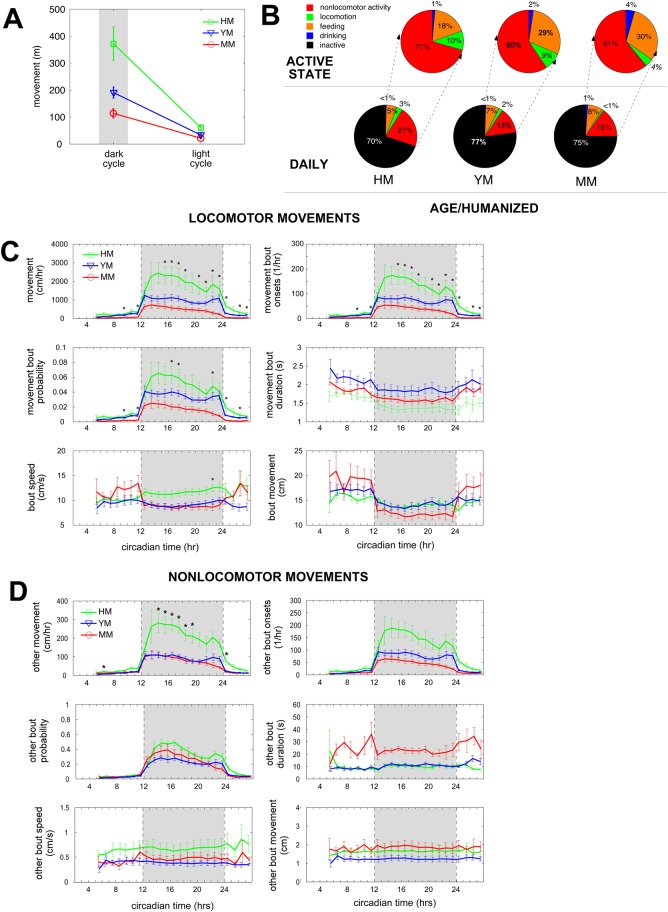
Mouse home cage behavior monitoring. Humanized mice (HM) have significantly more dark cycle movement as a result of higher dark cycle movement probability and greater dark cycle movement bouts. (A) Overall movement averages for dark cycle (grayed) and light cycle for humanized, young male (YM), and middle age male (MM) mice (green, blue, red traces respectively). Bars are ±one standard error of the mean. (B) Time budgets show that over 24 h, HM mice have significantly less inactive time compared to YM and MM mice, with a similar increase in nonlocomotor movements (bottom row). Active state time budgets between YM and MM mice are similar except that MM mice show less locomotion compared to YM mice. HM mice active state time budgets are similar to YM, except that HM mice show significantly more nonlocomotor movements, and significantly less time dedicated to feeding, compared to YM mice. (C) Locomotor movement properties. Note that HM mice show increased overall locomotion, locomotor probability, and locomotor bouts compared with either YM or MM mice (asterisks indicate time bins where HM mice significantly differ from YM and MM, Bonferroni corrected for 24 comparisons). (D) Nonlocomotor movement properties. HM mice show increased nonlocomotor movement (albeit one log less than locomotor movements) compared to YM and MM mice. (C,D) Bars are ±one standard error of the mean. No other properties demonstrated statistically significant differences. Overall, these data show that HM mice have increased dark cycle locomotion compared to YM and MM mice, and that this increase is a result of HM mice spending less time in the inactive state, and having greater locomotor probability and number of locomotor bouts (as well as greater overall nonlocomotor movement and a trend toward increased nonlocomotor bouts).